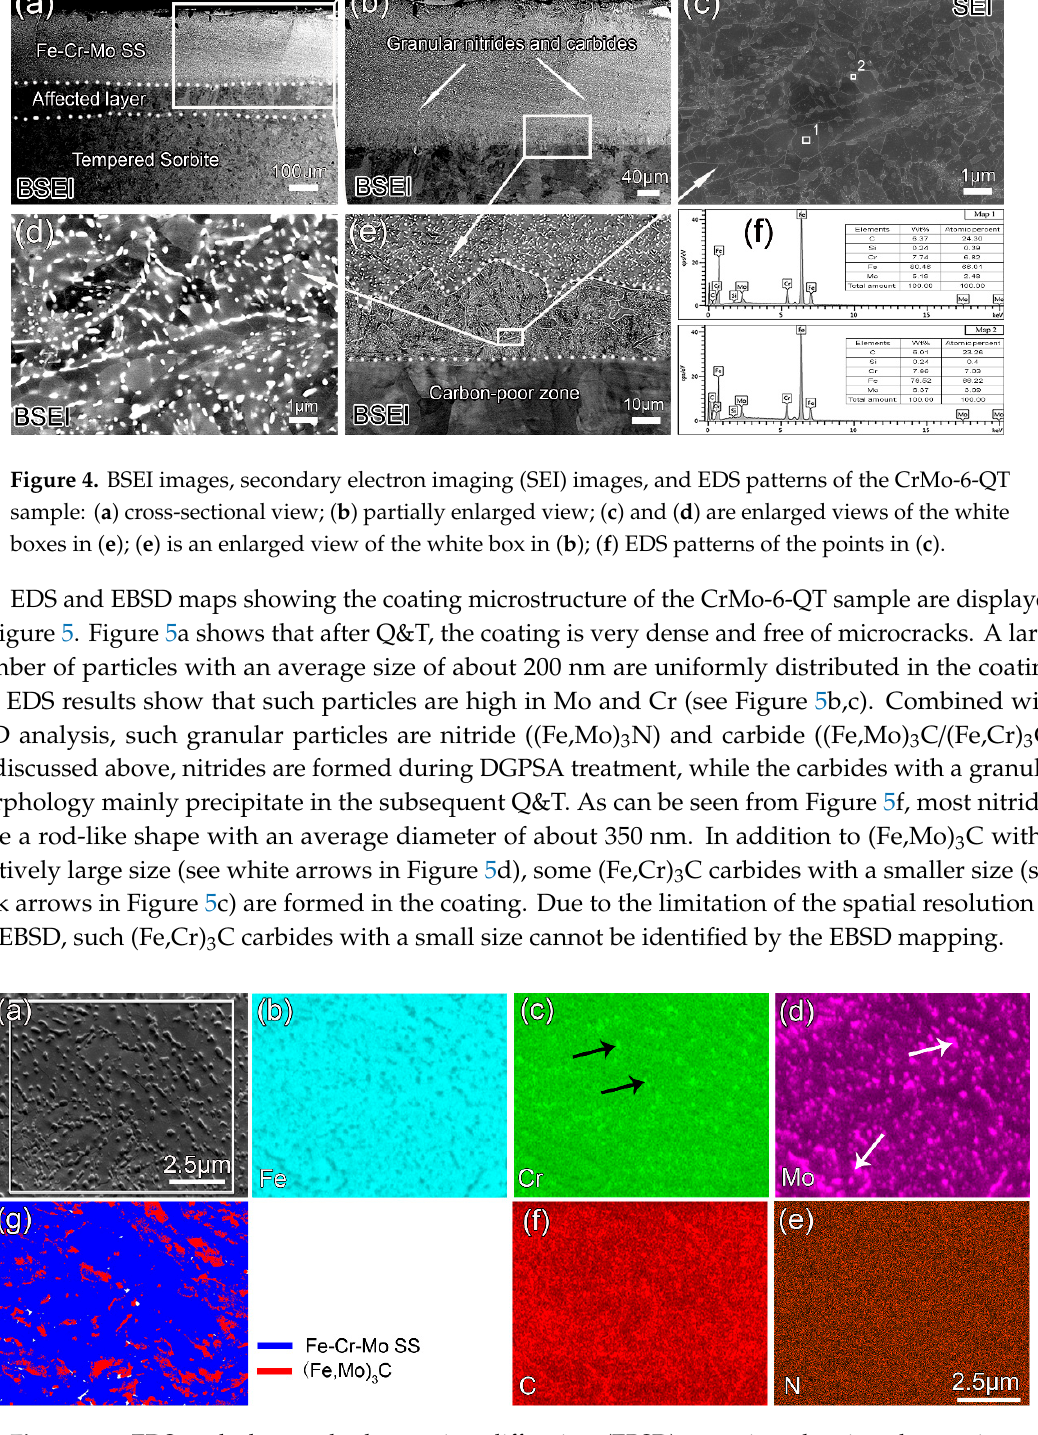
Figure 5. EDS and electron backscattering diffraction (EBSD) mapping showing the coating microstructure of the CrMo-6-QT sample: ( a ) SEI image; ( b-f ) EDS maps of the white box in (a); ( g ) EBSD phase composition map. All the images/maps were observed from the cross-sectional view of the sample.